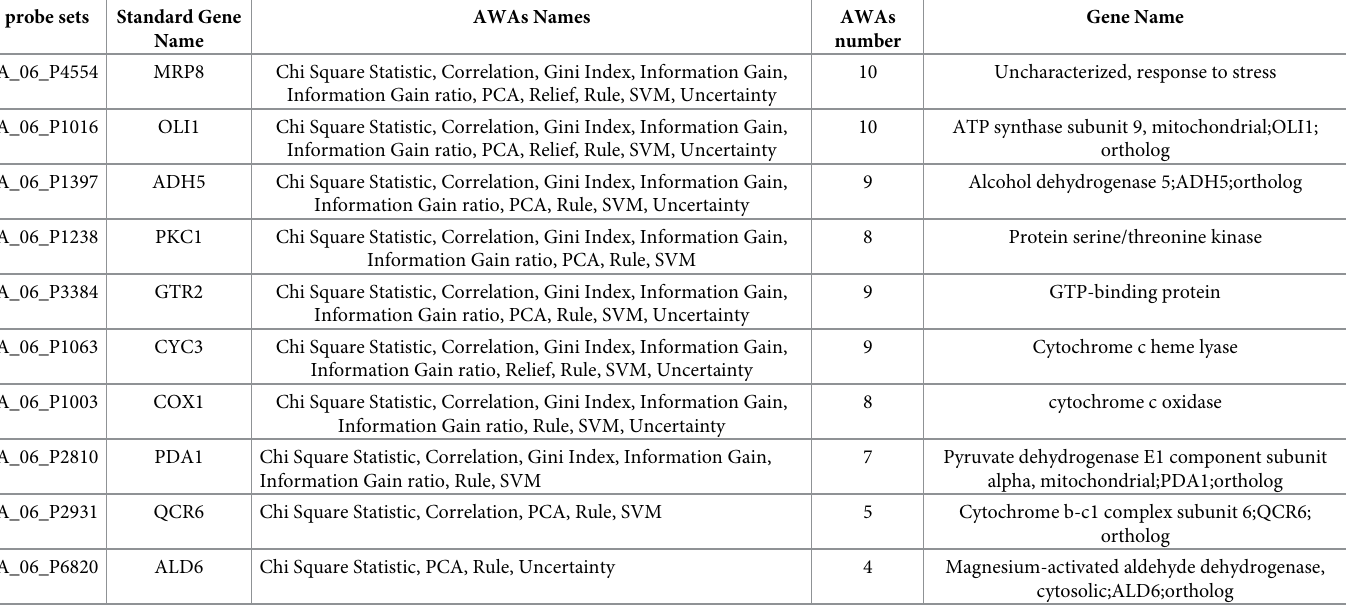
Table 1. Some of the informative probe sets identified by at least four AWAs. probe sets